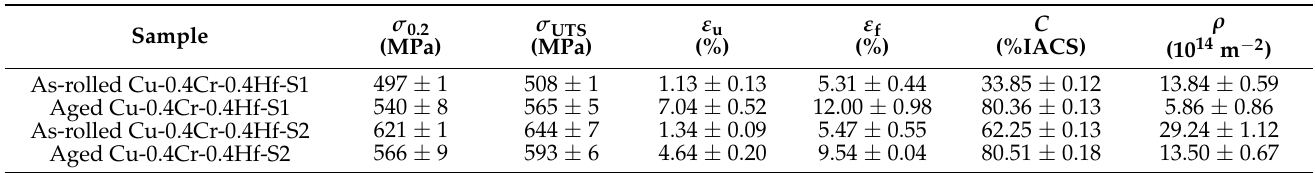
Table 1. Mechanical properties, electrical conductivity and dislocation density of Cu-0.4Cr-0.4Hf-S1 and Cu-0.4Cr-0.4Hf-S2.